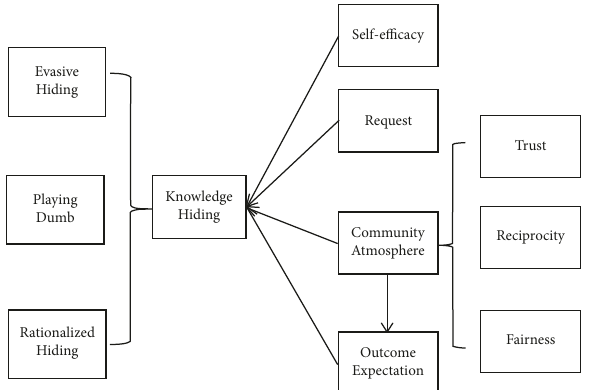
Figure 1: research model of influencing factors of knowledge hiding behavior.